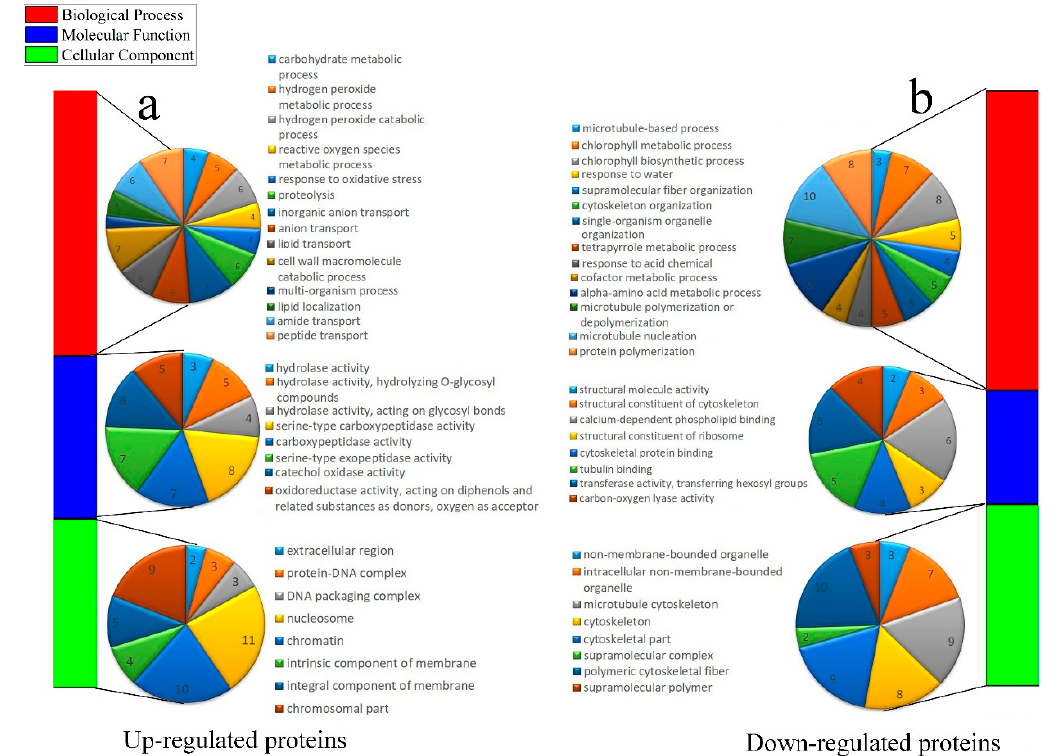
Figure 4. Gene Ontology (GO) enrichment analysis of DAPs. ( a ) Dispersion of the up-regulated proteins with GO annotation. Diverse shading squares express to various terms, including cellular component, molecular function, and biological process. The number, some of the up-regulated proteins in each second-level term, was appeared in a pie chart. ( b ) Distribution of the down-regulated proteins with GO annotation. Diverse colors squares symbolize to various terms, including cellular component, molecular function, and biological process. Number, the quantity of the down-regulated proteins in each second-level term has appeared in a pie chat.